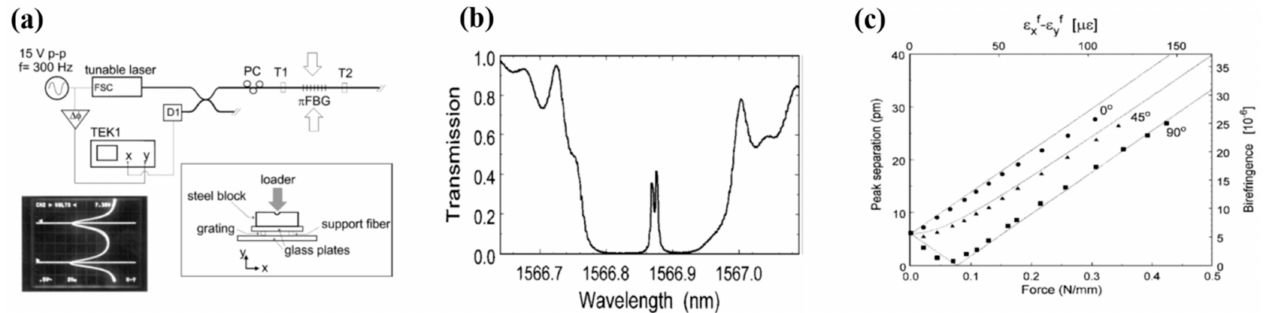
Figure 11. ( a ) The proposed PS-FBG-based sensing system for measurement of the transverse load along a fiber. ( b ) Transmission spectra of the adopted PS-FBG without load. ( c ) The relationship between the peak wavelength separation (corresponding to the birefringence) and the applied forces in transverse direction. Adapted with permission from ref. [88]. © The Optical Society.